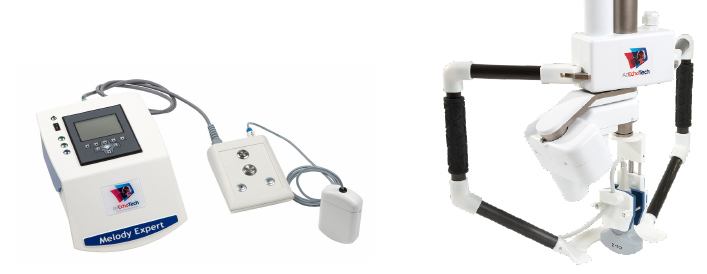
Figure 7. Adechotech Melody